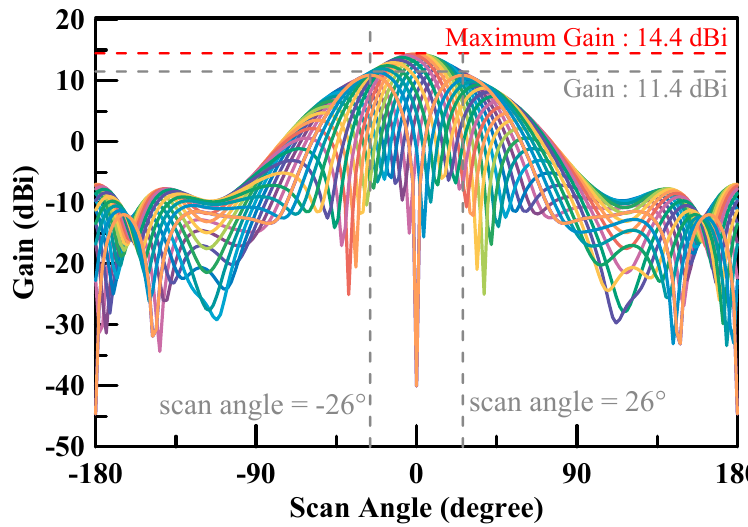
Figure 12. Simulation results of the beam steering pattern at 28 GHz (Y-cut).